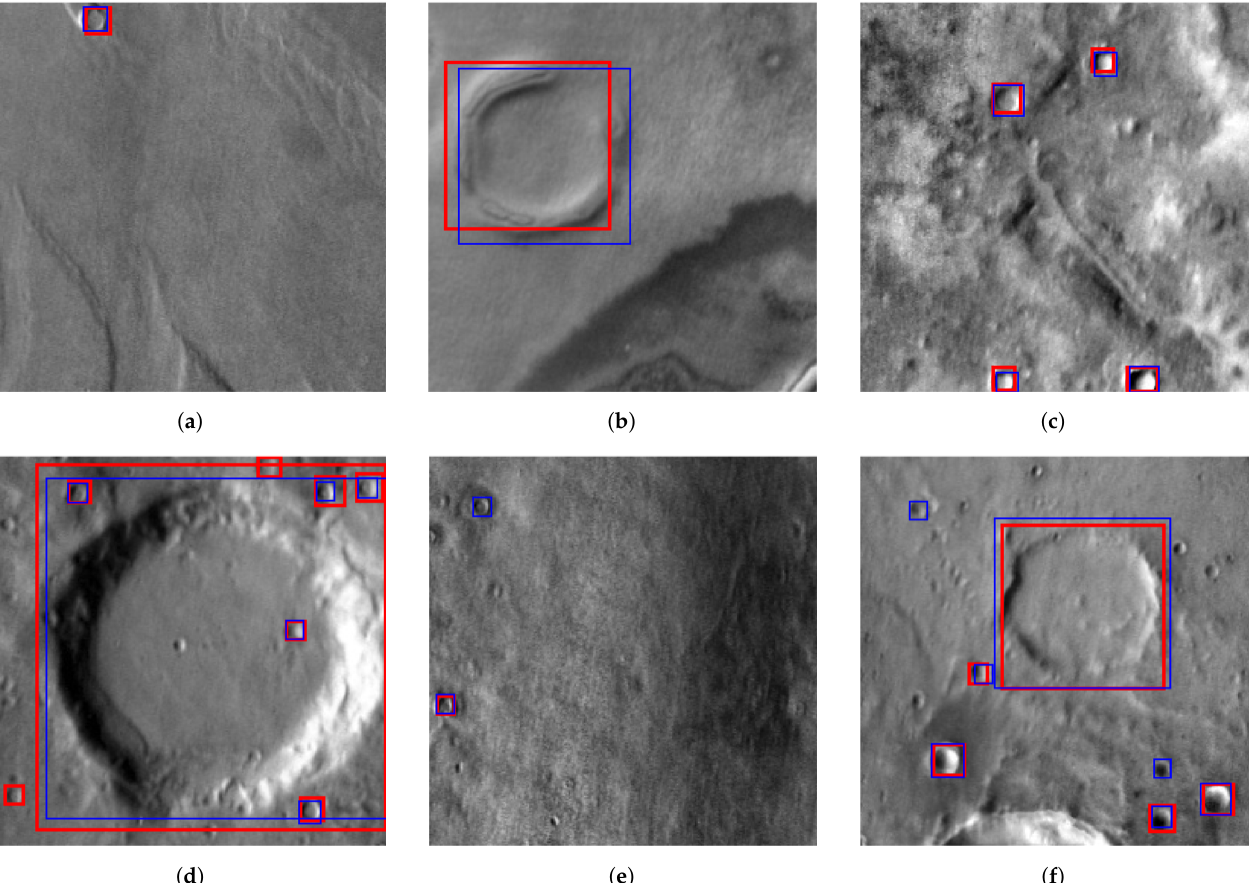
Figure 5. ( a – f ) illustrate sample detection results for Mars craters at different locations on the Mars surface. The ground-truth Bounding Boxes (BBOX) are labeled in red and model prediction results are the blue